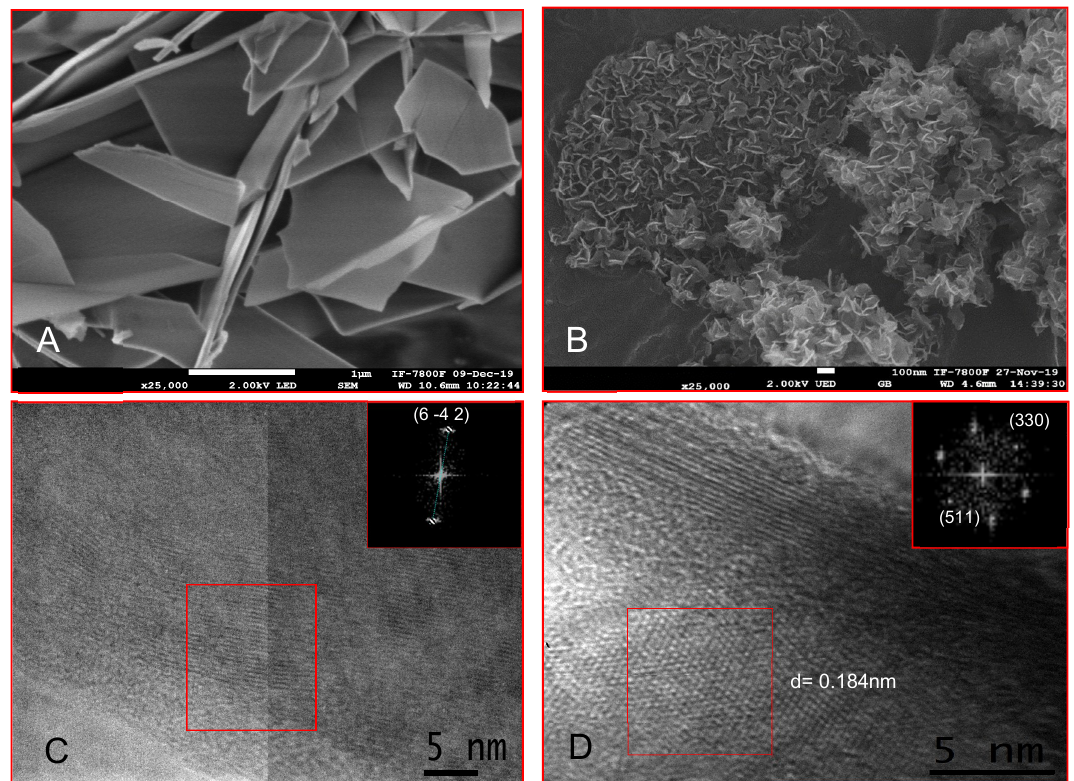
Figure 7. SEM and TEM micrographs of the microstructure and morphology of samples obtained after the SPB assay. ( A ) SEM images control sample, ( B ) SEM images experimental sample, ( C ) bright-field HRTEM micrographs of OCP (control), ( D ) HRTEM fringes, and FFT analysis corresponding to the HA crystal structure (experimental).